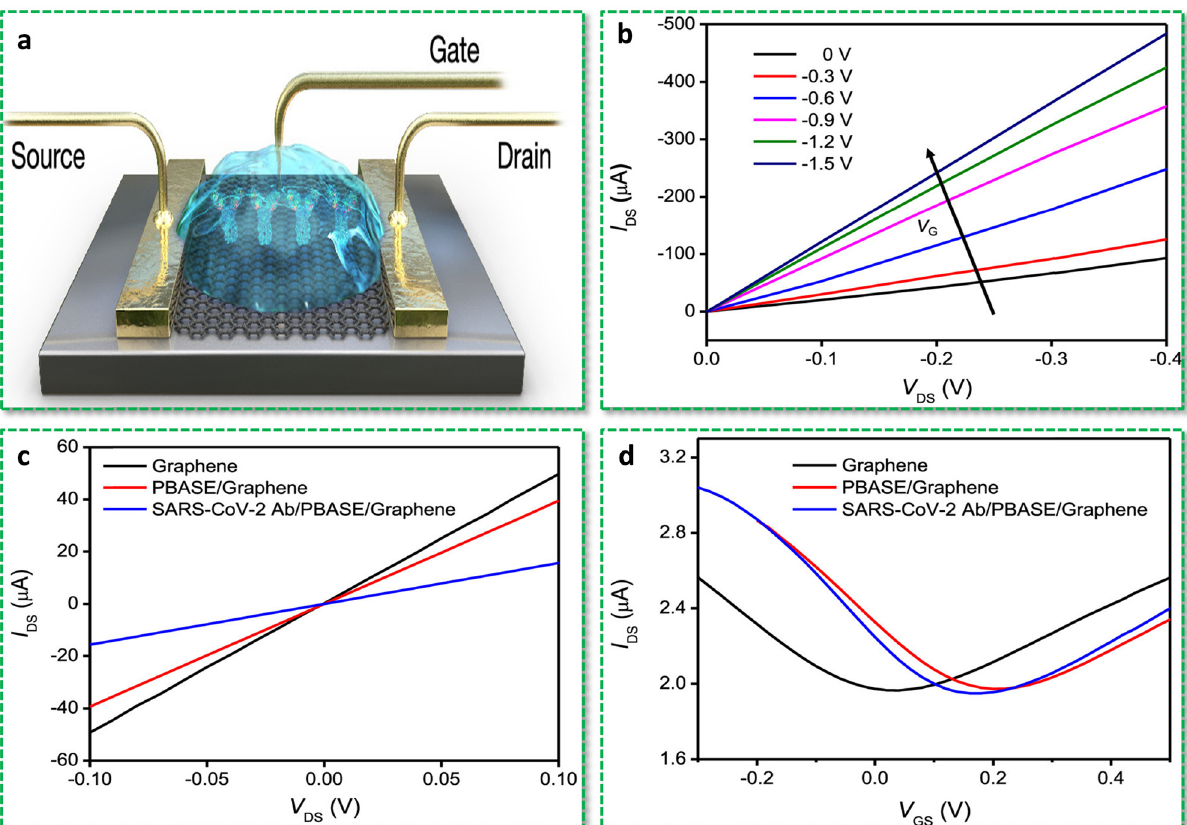
Figure 4: ( a ) Schematic diagram of COVID - 19 FET sensor, ( b ) I DS – V DS output curves, ( c ) current – voltage ( I – V ) characteristics, and ( d ) measurement of transfer curves [ 75 ]